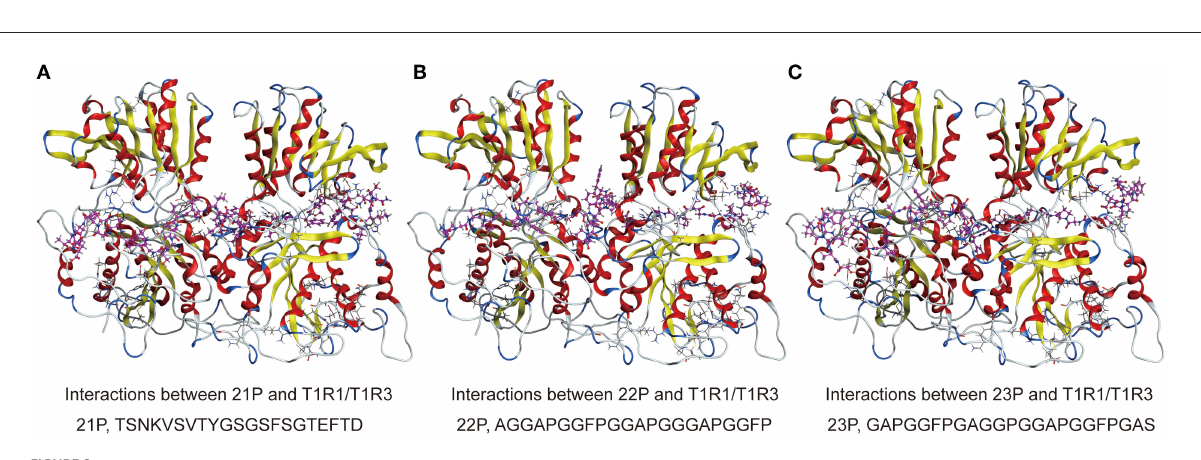
FIGURE8 (A–C) 3D ligand interactions between peptides and T1R1/T1R3 amino acids. T1R1/T1R3, the cartoon model; peptides, the purple ball and the stick model.